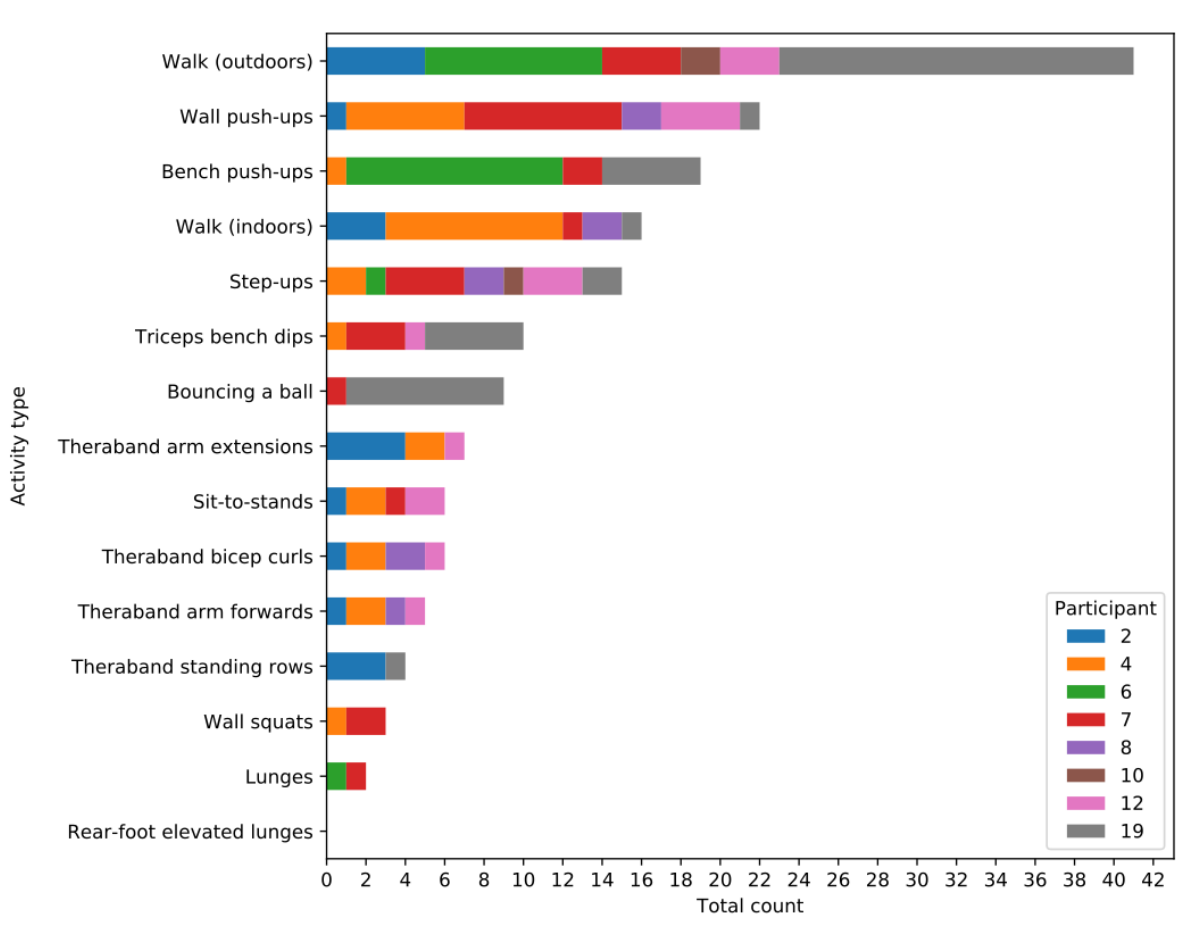
breathlessness score was 3.8 (SD 1.3).